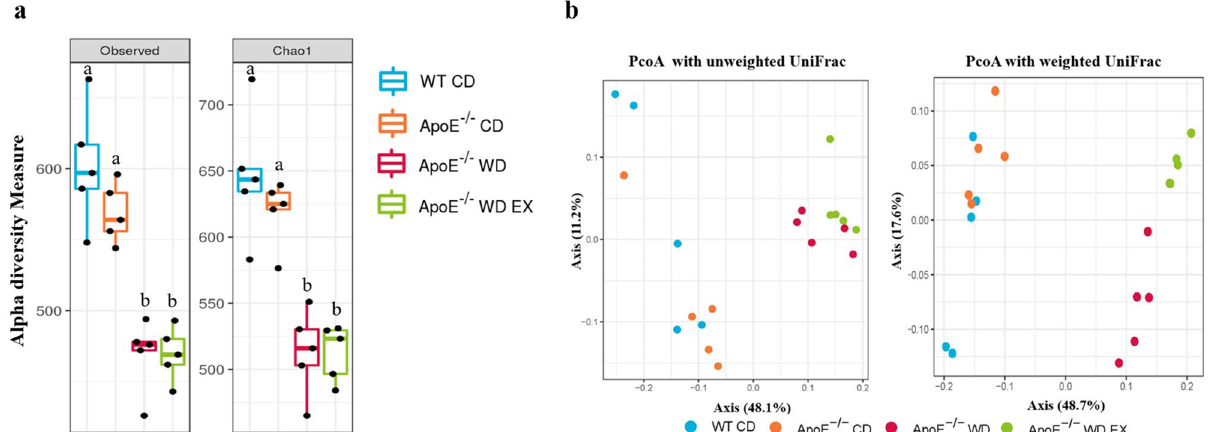
Figure 3. Effects of endurance exercise on gut microbiota composition in ApoE knockout mice. The ( a ) α-diversity (observed and Chao1 index) and ( b ) β-diversity (unweighted and weighted UniFrac PcoA) in the WT CD, ApoE CD, ApoE WD, and ApoE WE EX groups are indicated by the same colors used in Fig. 2. The line inside the box represents the median, and the whiskers represent the lowest and highest values within the 1.5 interquartile range. Different superscript letters (a and b) indicate significant differences ( P < 0.05) in one- way